Question: Provide a one-line summary of what is displayed.
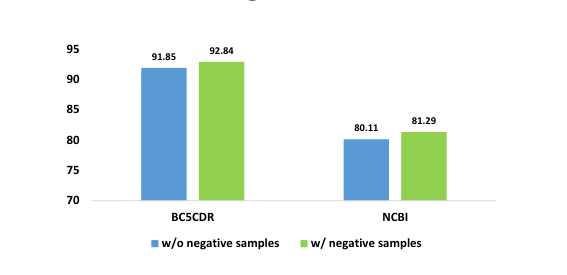
Answer: LLM performance on without (w/o) negative samples and with (w/) negative samples